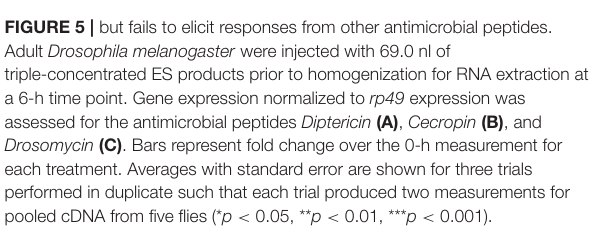
FIGURE 5 | but fails to elicit responses from other antimicrobial peptides. Adult Drosophila melanogaster were injected with 69.0 nl of triple-concentrated ES products prior to homogenization for RNA extraction at a 6-h time point. Gene expression normalized to rp49 expression was assessed for the antimicrobial peptides Diptericin (A) , Cecropin (B) , and Drosomycin (C) . Bars represent fold change over the 0-h measurement for each treatment. Averages with standard error are shown for three trials performed in duplicate such that each trial produced two measurements for pooled cDNA from five flies (* p < 0.05, ** p < 0.01, *** p <